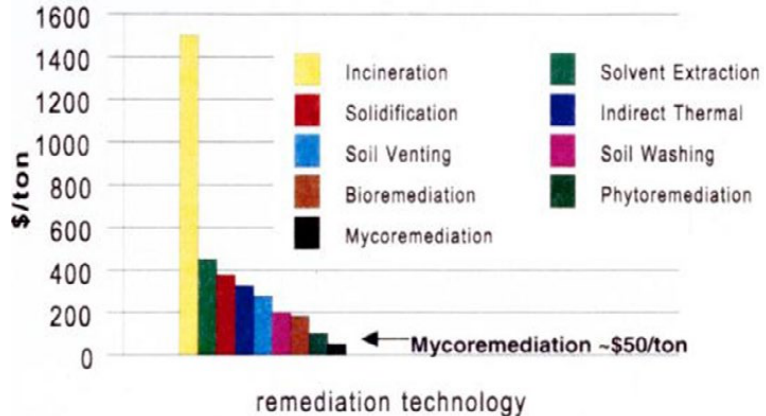
Fig. 5: Economic cost comparison of the different remediation techniques used in soil remediation (Stamets, 2013)